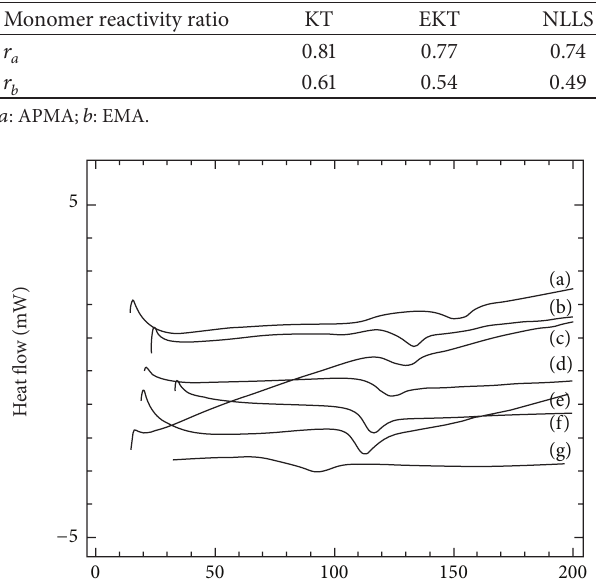
Figure 6: DSC thermograms of investigated copolymers; (a) poly(APMA), APMA unit in copolymer; (b) 0.88, (c) 0.56, (d) 0.38, (e) 0.25, (f) 0.15, (g)